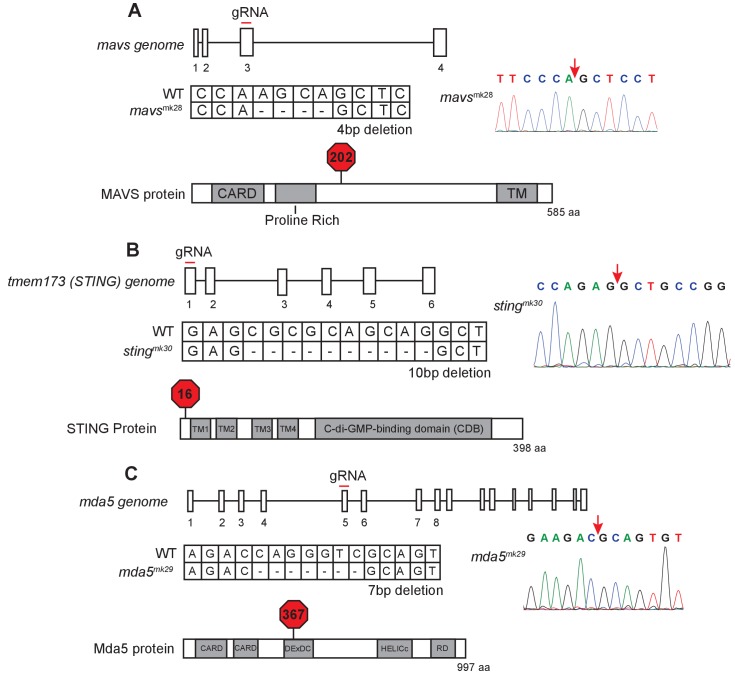
Mutation of zebrafish orthologs of mavs, sting, and mda5.(A) Schematic of mutation in mavs including position of targeted gRNA, sequence information of the mutation, and location of predicted STOP codon. (B) Schematic of mutation in sting including position of targeted gRNA, sequence information of the mutation, and location of predicted STOP codon. (C) Schematic of mutation in mda5 including position of targeted gRNA, sequence information of the mutation, and location of predicted STOP codon. The site of deletion is indicated with a red arrow on the sequence trace.